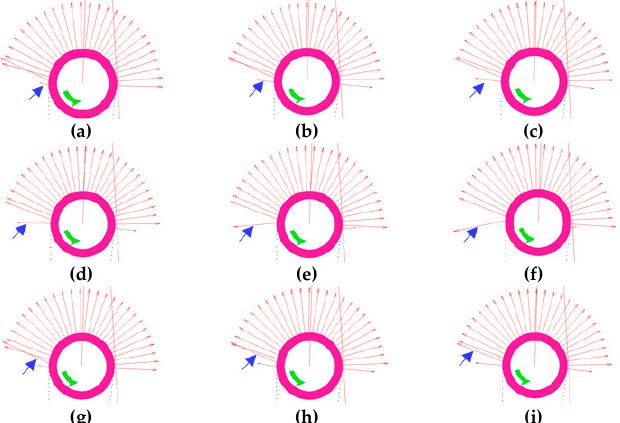
Figure 14. Dynamic force line on the friction pulley during the transmission process.